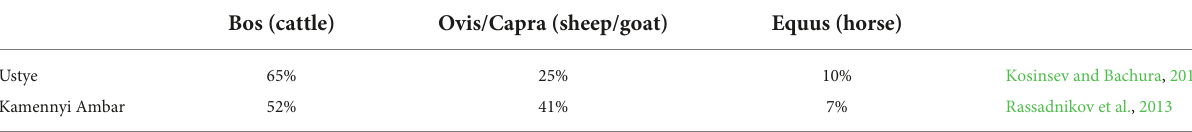
TABLE 2 The proportion of identifiable livestock bones within the faunal assemblage (Sintashta-Petrovka period) from Ustye (1984–1991) and Kamennyi Ambar excavation. Bos (cattle)